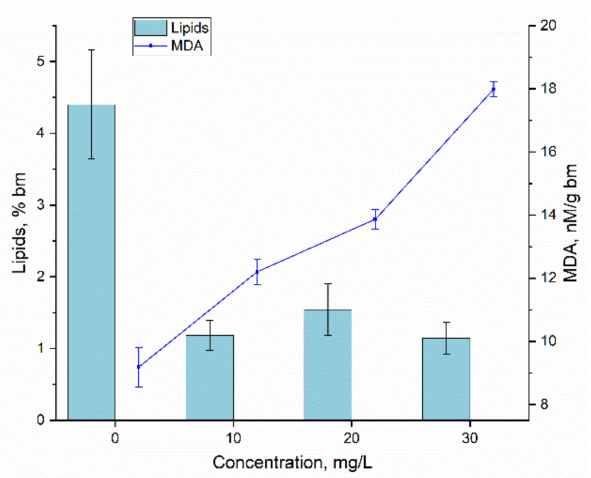
Figure 9. The content of lipids and MDA in Arthrospira platensis exposed to Er(III) at concentrations of 10–30 mg/L a— p < 0.05 for the difference between control and experimental